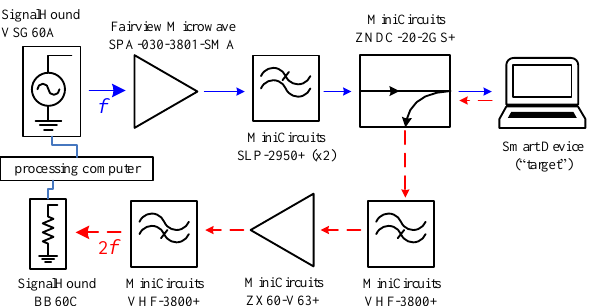
Figure 2. Block description of the wired configuration of the radar system designed to detect home consumer electronics.